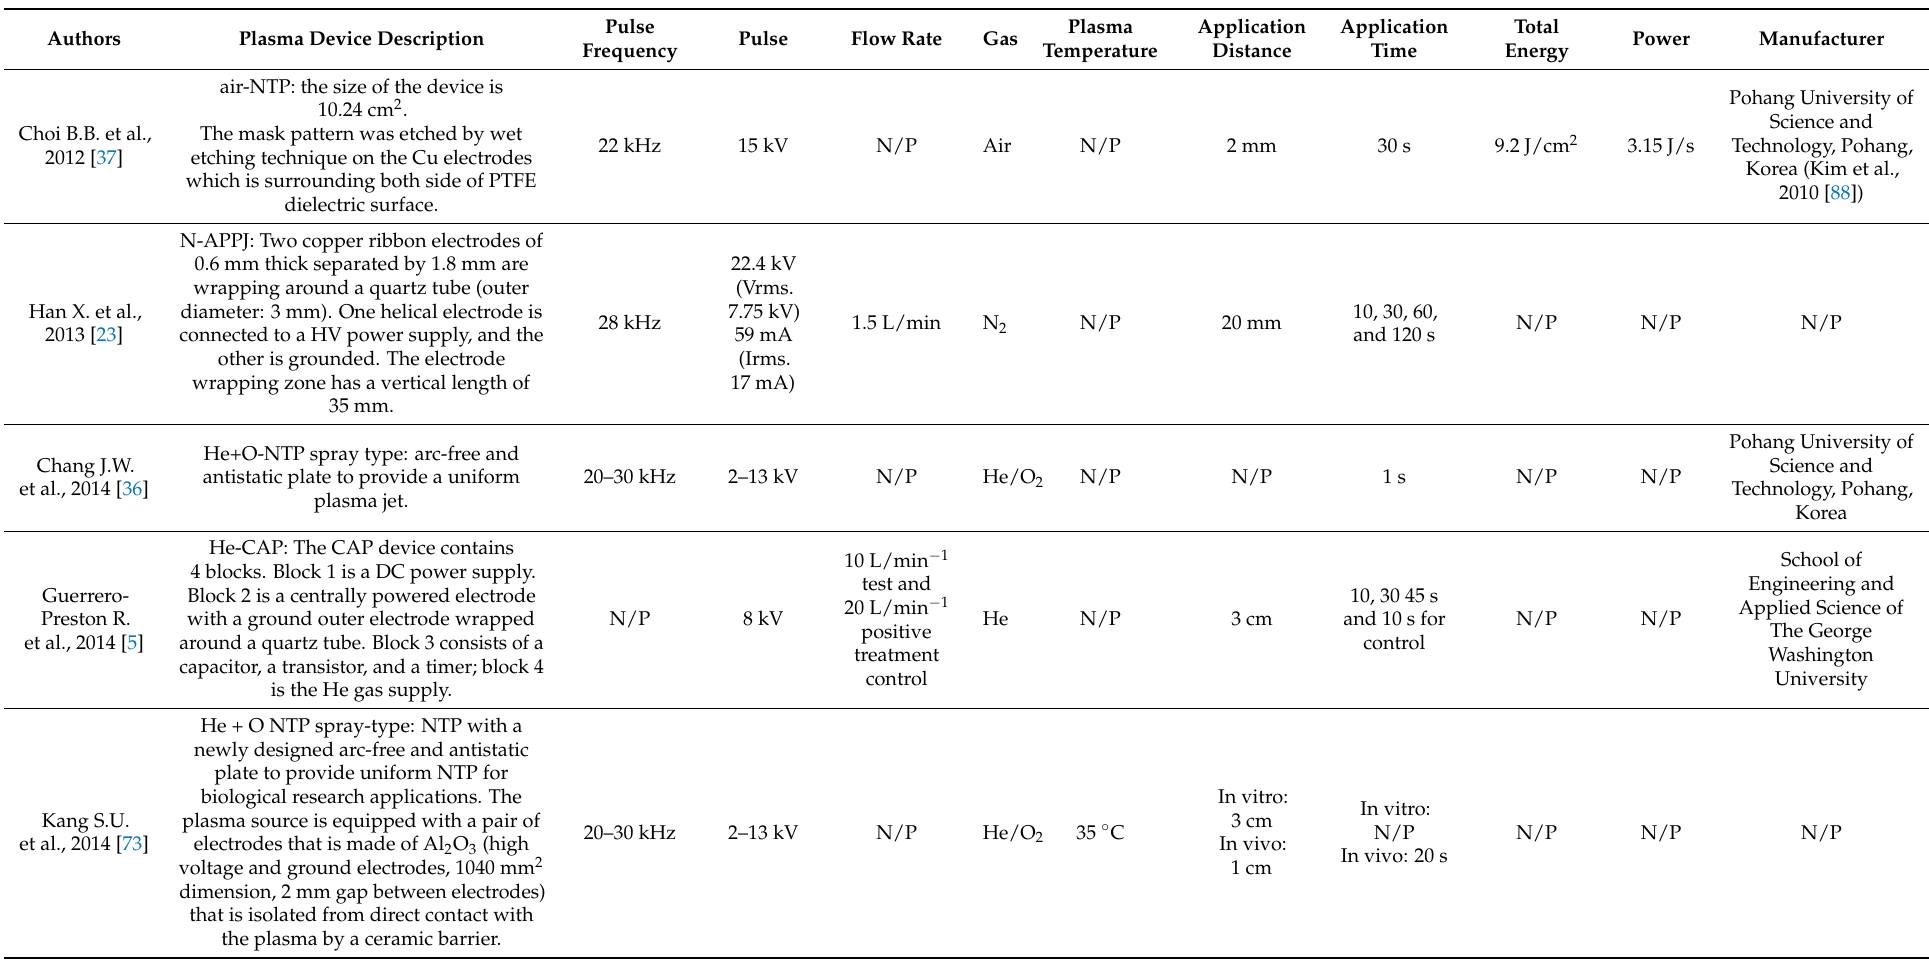
Table 4. Characteristics of plasma